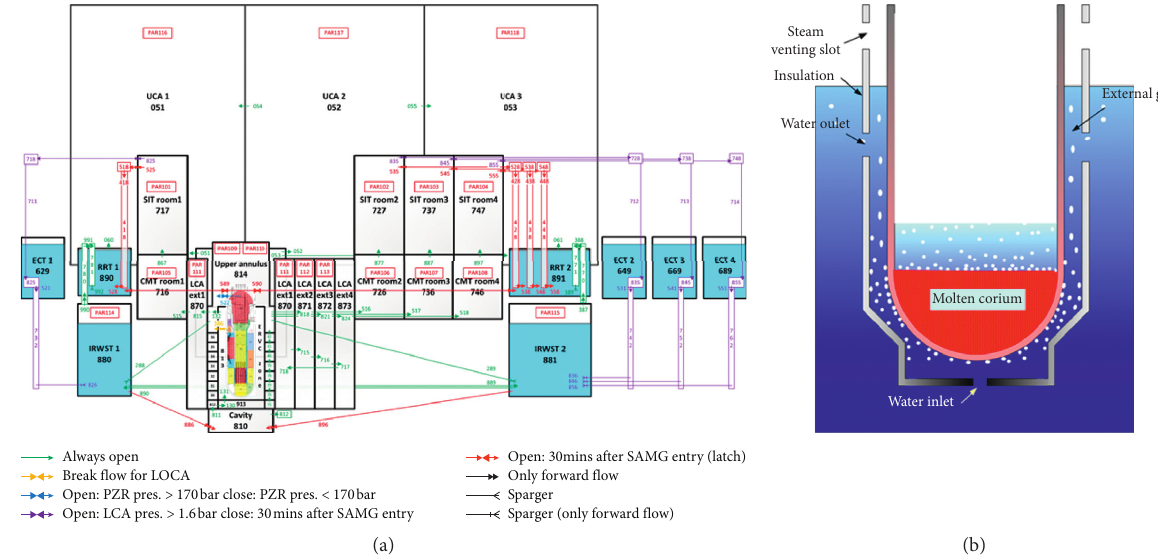
Figure 3: (a) MELCOR nodalization for SMART containment and (b) conceptual view of ex-reactor vessel